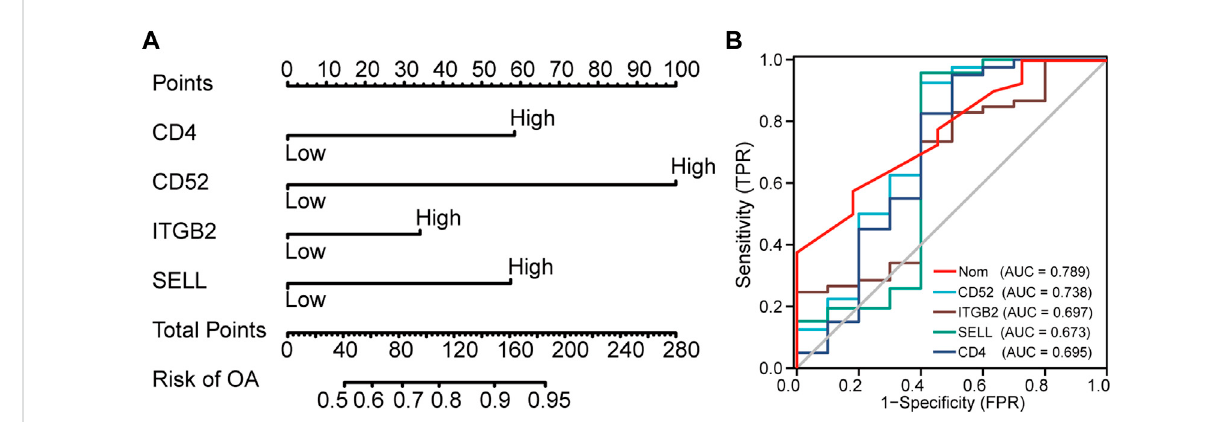
FIGURE 5 Nomogram to predict the risk of OA. (A) Nomogram model of hub genes. (B) ROC curves to assess the diagnostic ef fi cacy of our nomogram model and each hub gene.